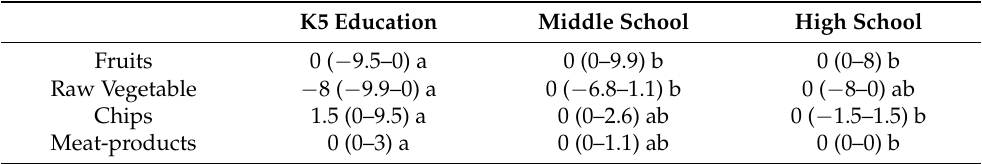
Table 4. Changes in foods consumed by grade taught. One-way ANOVA rank tests were used. Significant changes are represented by non-overlapping letters across the